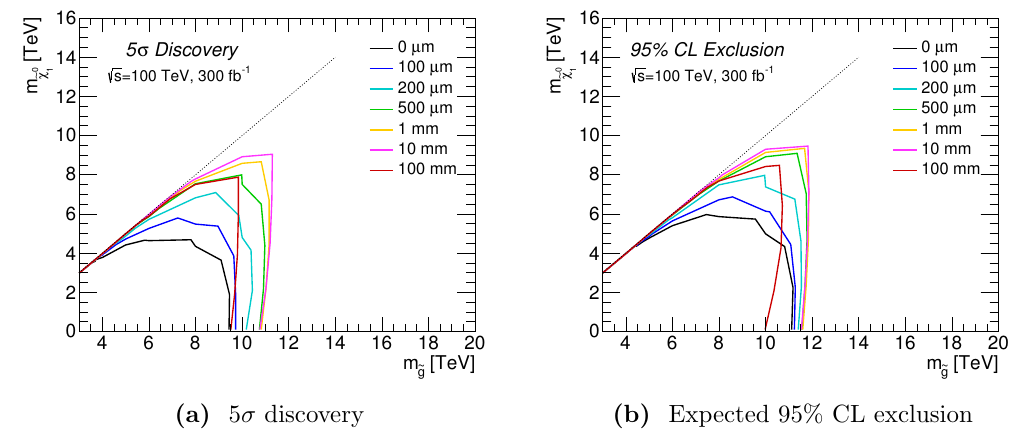
Figure 23. 5 (cid:27) discovery reaches and expected 95% CL exclusion limits for gluinos with di(cid:11)erent c(cid:28) ~ g , for an integrated luminosity of 300 fb (cid:0) 1 .